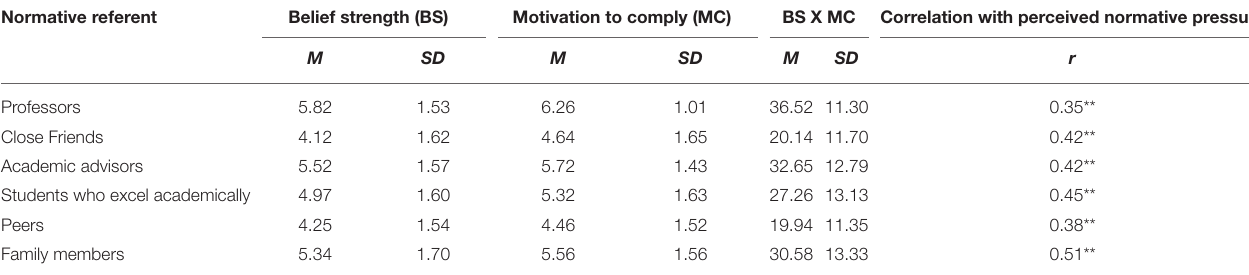
TABLE 4 | Injunctive normative beliefs and correlations with normative pressure. Normative referent Belief strength (BS) Motivation to comply